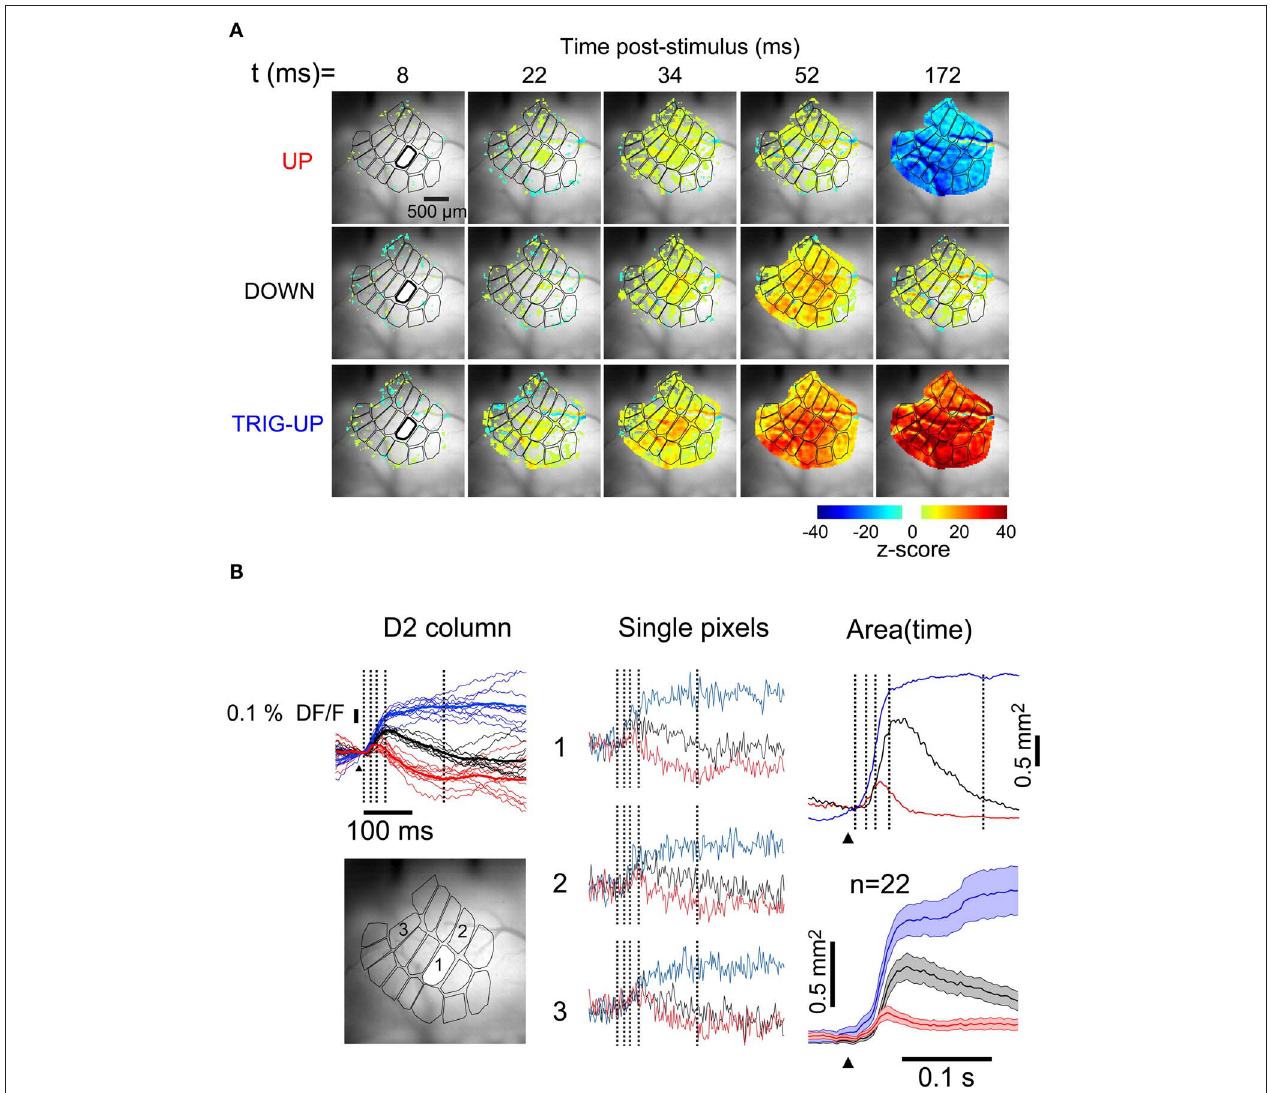
times of frames in A . Thin lines: individual trials. Thick lines: average of thin lines. (Middle) Single pixel traces in the different states. Locations indicated on grayscale frame at bottom left. (Right, upper panel) Thresholded depolarized areas as a function of time. Vertical lines indicate times of frames in A . (Right, lower panel) Average depolarized areas as a function of time ( n = 22 experiments). Shaded area indicates ±